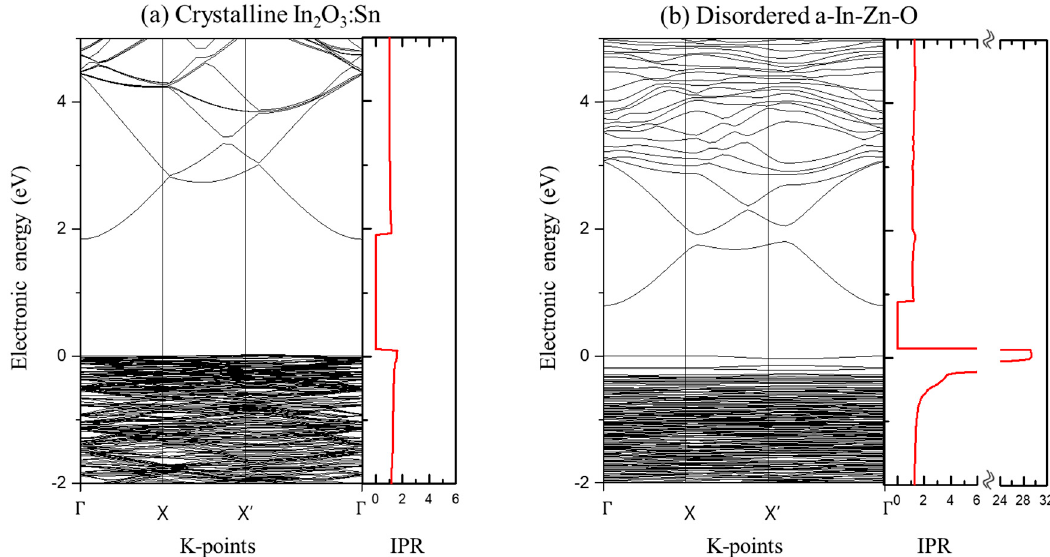
Figure 3. Electronic structures and IPR of ( a ) crystalline In 55 Sn 9 O 96 and ( b ) disordered amorphous In 54 Zn 8 O 88 generated by the ab-initio molecular dynamics simulation are compared. ( a ) was calculated by using an In 2 O 3 supercell containing 160 atoms, where an In atom was replaced by a Sn atom. ( b ) was calculated using a supercell with 150 atoms.